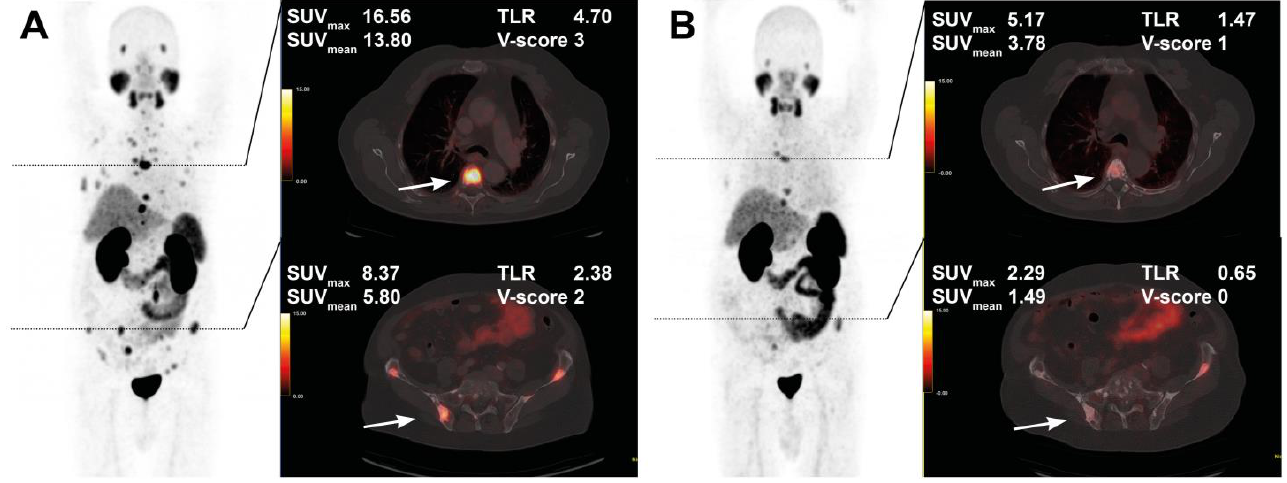
Figure 4. Treatment response in a 76-year-old patient after 4 cycles of RLT with cumulative 32.0 GBq [ 177 Lu]Lu-PSMA-617. Maximum intensity projection (MIP) images (left) with cross-section fusion images in a thoracic and pelvic plane at baseline ( A ) and after RLT ( B ). Lesions (white arrows) show response to RLT, with the upper lesion in the thoracic spine maintaining detectable residual activity.